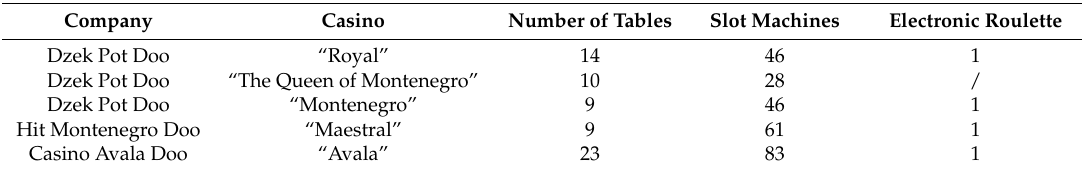
Table 4. Casino equipment in Montenegro.